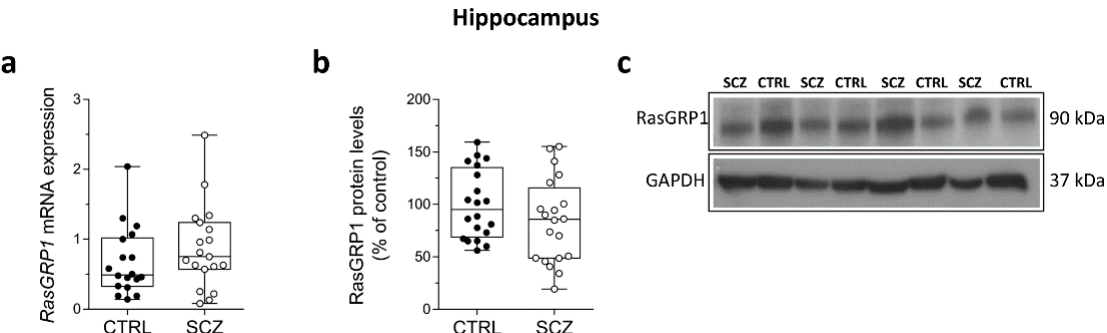
Figure 4. Unaltered RasGRP1 mRNA and protein levels in the hippocampus of schizophrenia patients. Expression levels of ( a ) RasGRP1 mRNA in the post-mortem hippocampus of SCZ-affected patients (SCZ) ( n = 19) and control subjects (CTRL) ( n = 18). Quantification of western blot analysis of ( b ) RasGRP1 protein levels in the total homogenates of post-mortem hippocampus of SCZ-affected patients (SCZ) ( n = 20) and control subjects (CTRL) ( n = 20). The variations of RasGRP1 protein levels in patients affected by SCZ are expressed as percentage (%) of the control subjects. All markers were normalized to GAPDH for variations in loading and transfer; ( c ) representative images of immunoblots of RasGRP1 performed in the hippocampus of SCZ patients and control subjects. Each dot represents value from a single subject. Unpaired t -test was performed in all analyses reported.